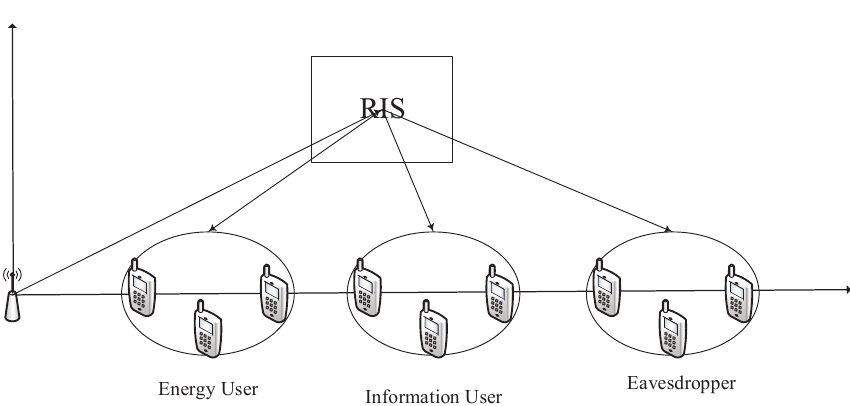
Figure 1. Simulation